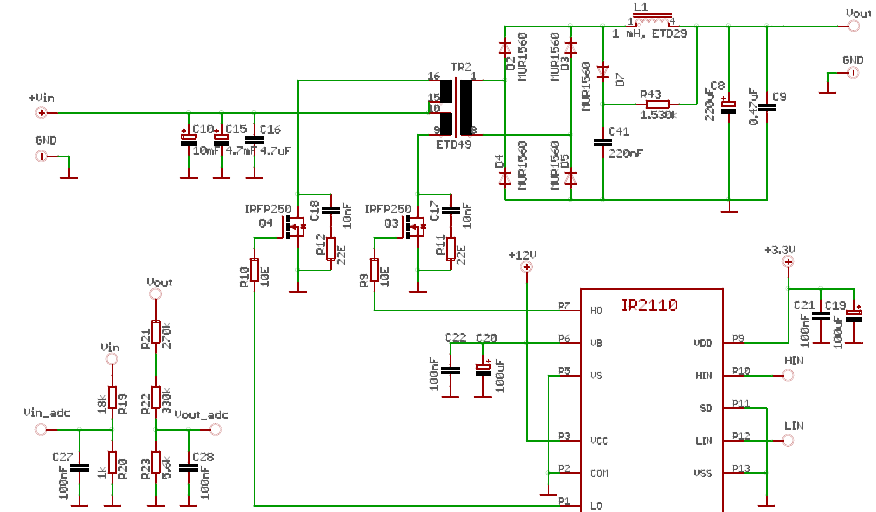
Figure 5. Electrical schematic of push – pull converter.